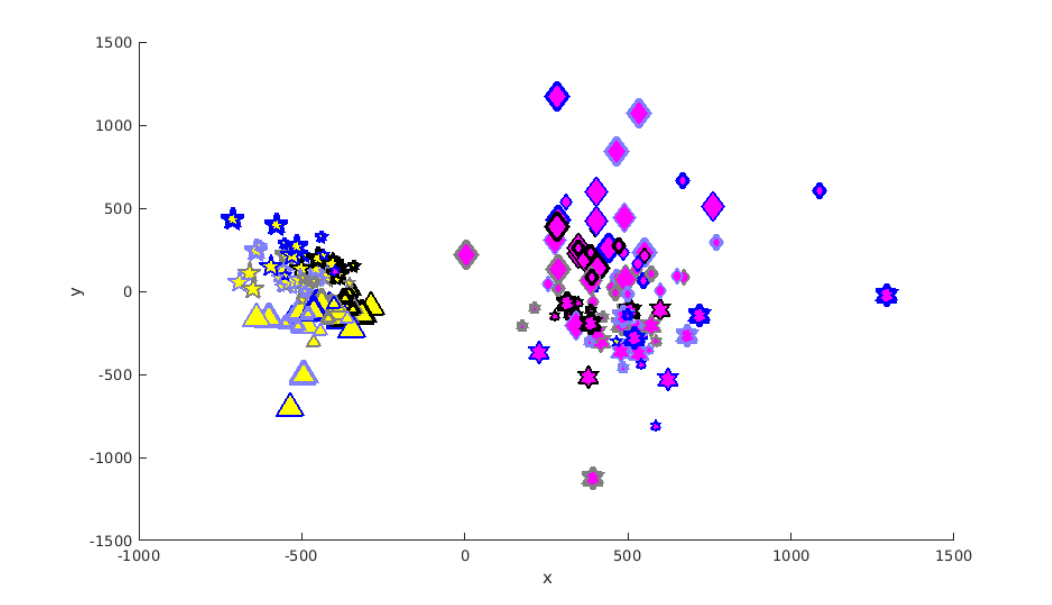
Figure 6. Results of the multidimensional scaling into three dimensions for the participants “Subject 1” and “Subject 2”. The axes of the three-dimensional projection space are labelled with x and y . The z -axis is pointing to the viewer. Use of markers equivalent to Figure 5, legend see